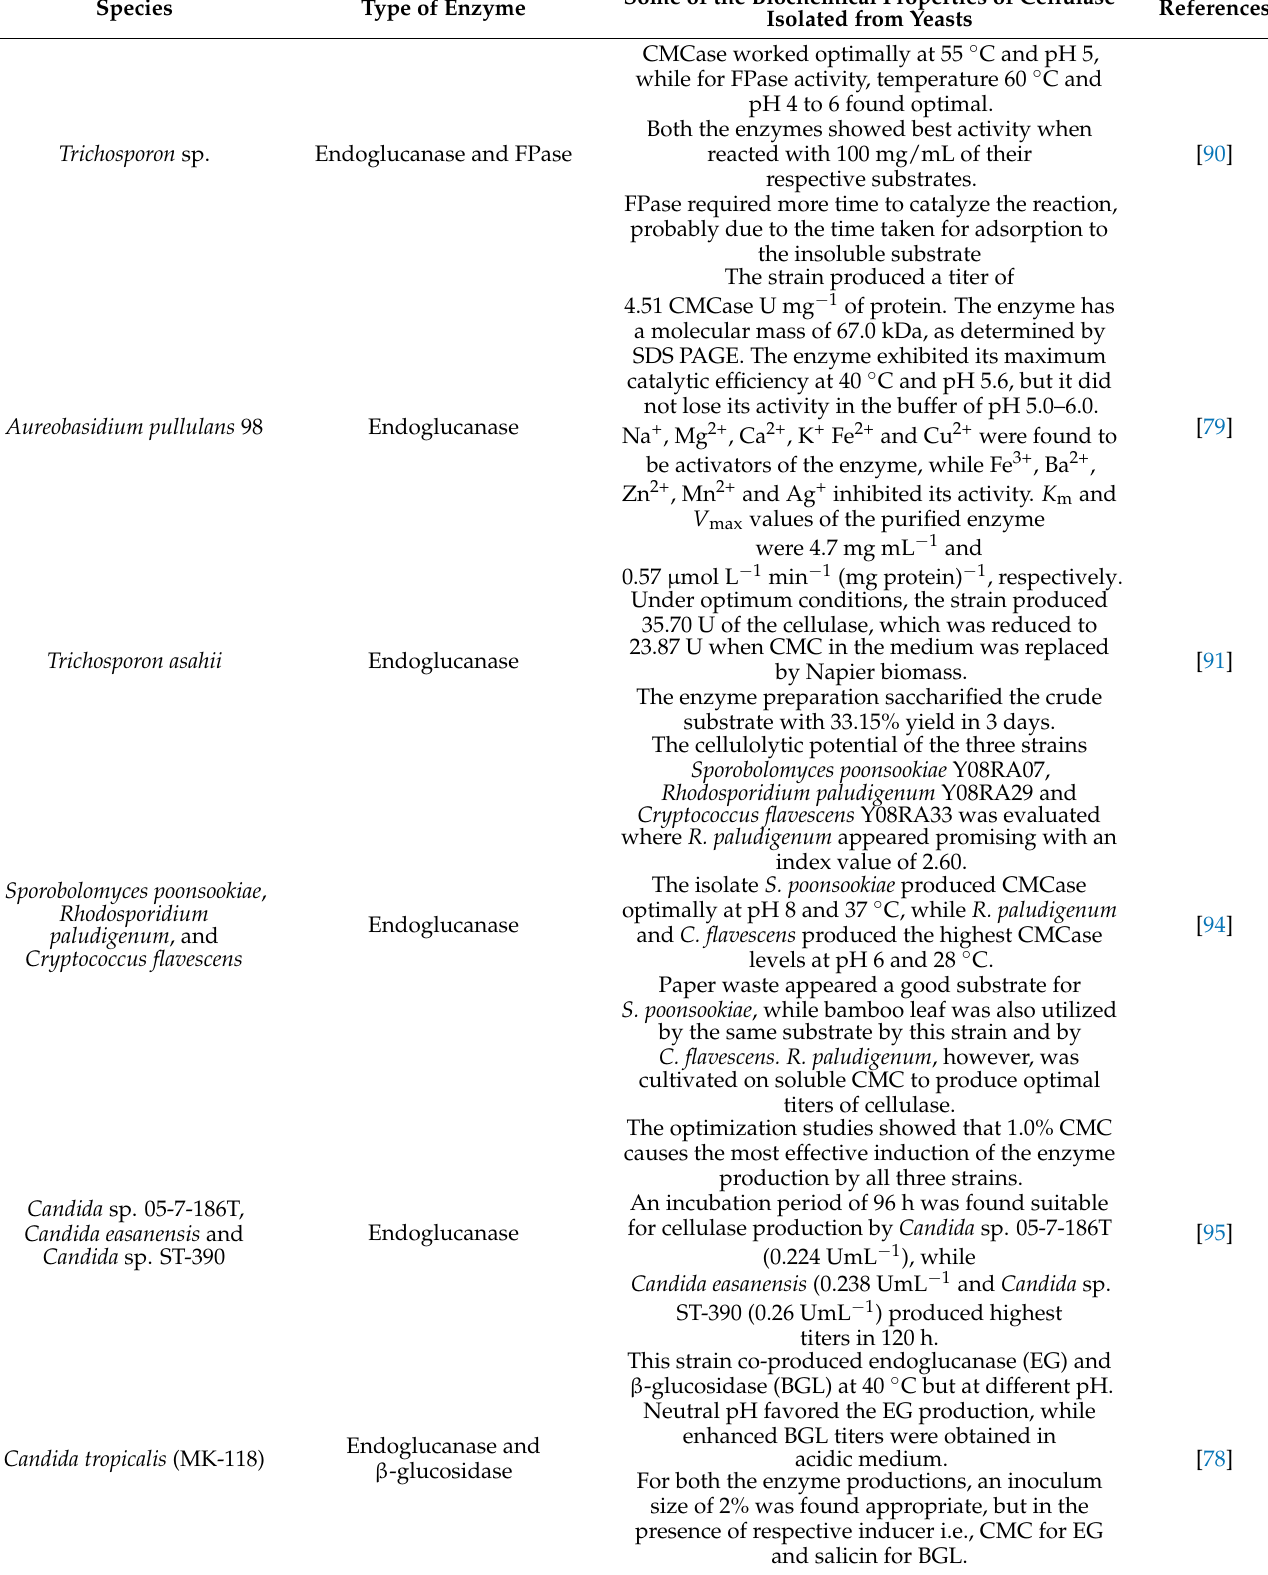
Table 3. Some biochemical properties of cellulases isolated from